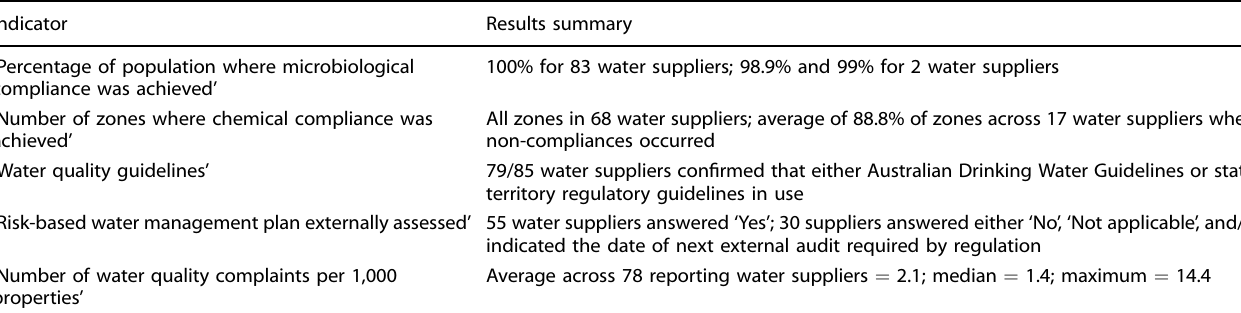
Table 1. Drinking water quality summary statistics in Australia ’ s Urban National Performance Report, 2018 – 19.